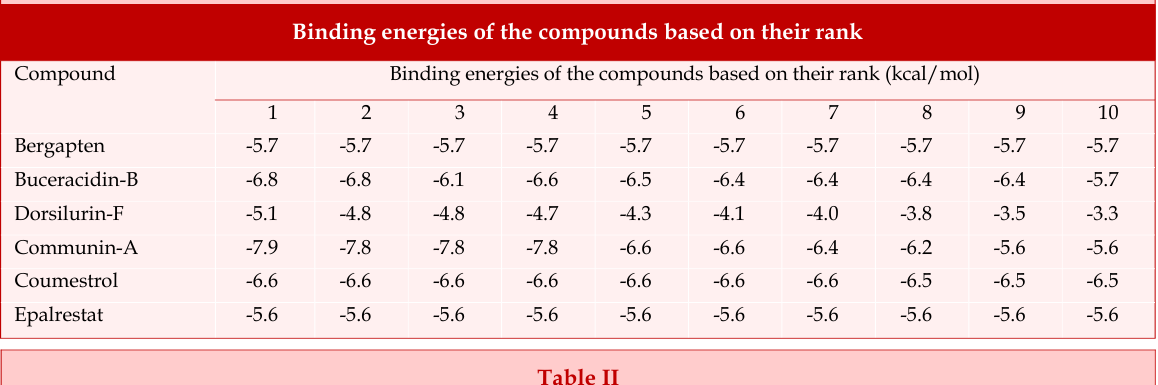
Binding energies of the compounds based on their rank (kcal/mol) Compound